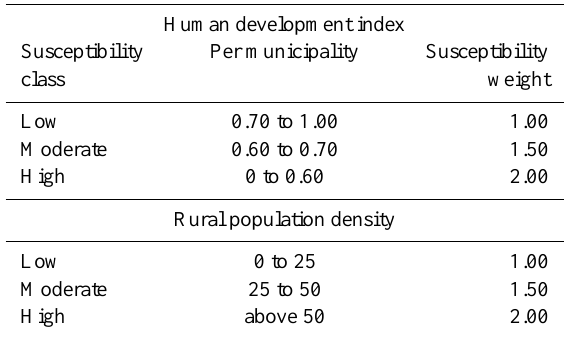
Table 6. Classes and weights of the parameters used for social qual- ity